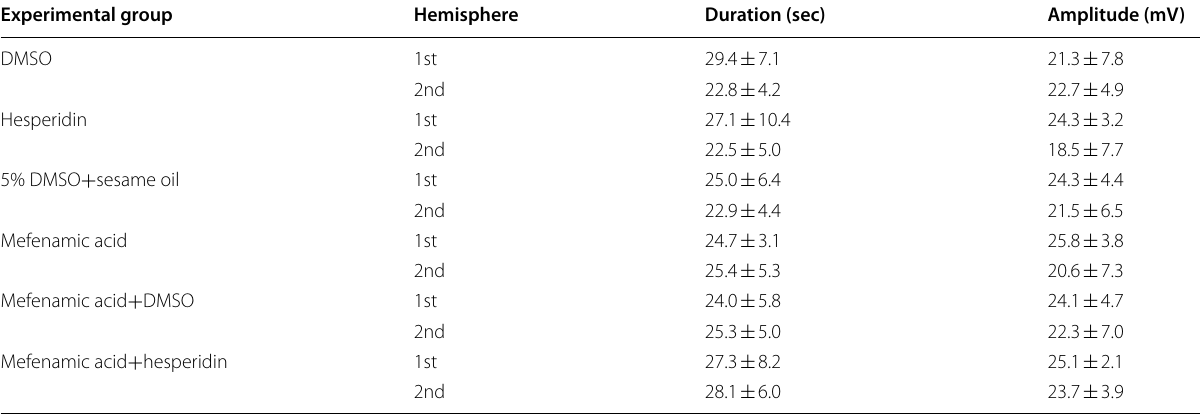
Table 2 Amplitude and duration of the first CSD detected at the posterior electrode Experimental group